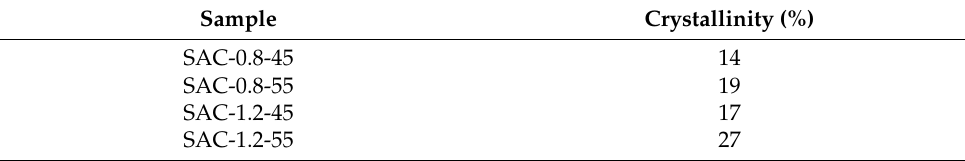
Figure 5. The XRD spectrum of SA/AKP/CNCs composite fiber. Table 3. The crystallinity of SA/AKP/CNCs composite fiber.